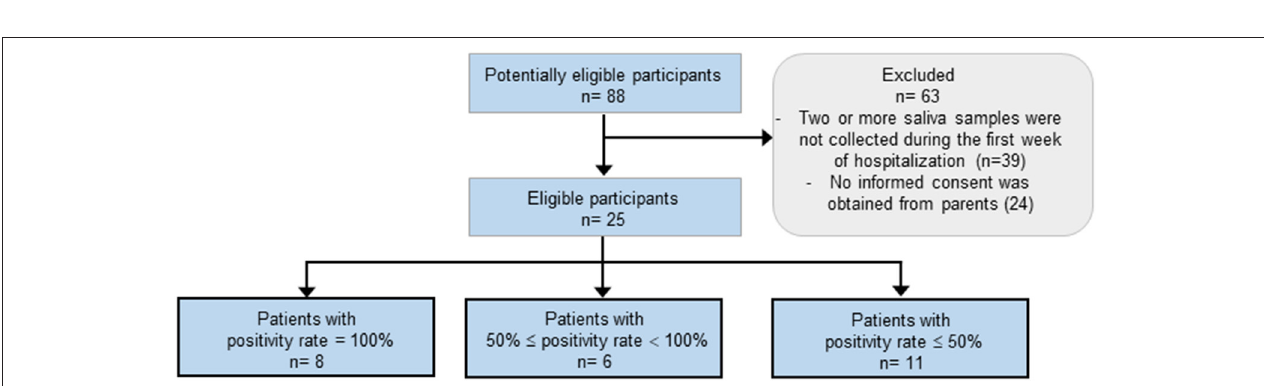
FIGURE 2 | Flow of hospitalized pediatric patients with confirmed COVID-19 whose results were used to calculate the positivity rate during the first week of stay. The characteristics of these participants are shown in Table 3 .